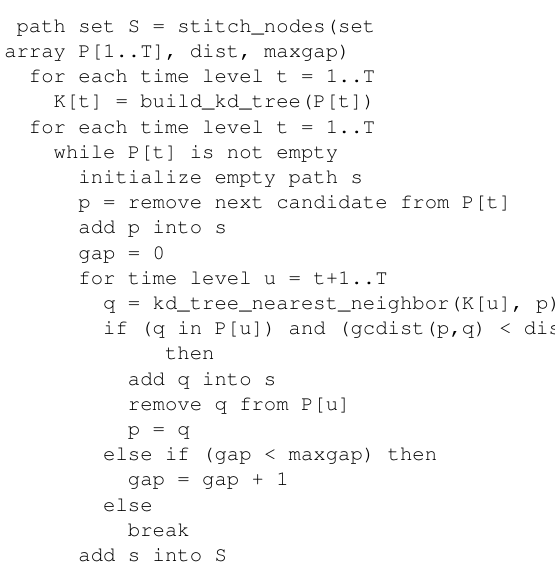
For simplicity, k -d trees are constructed at each time level